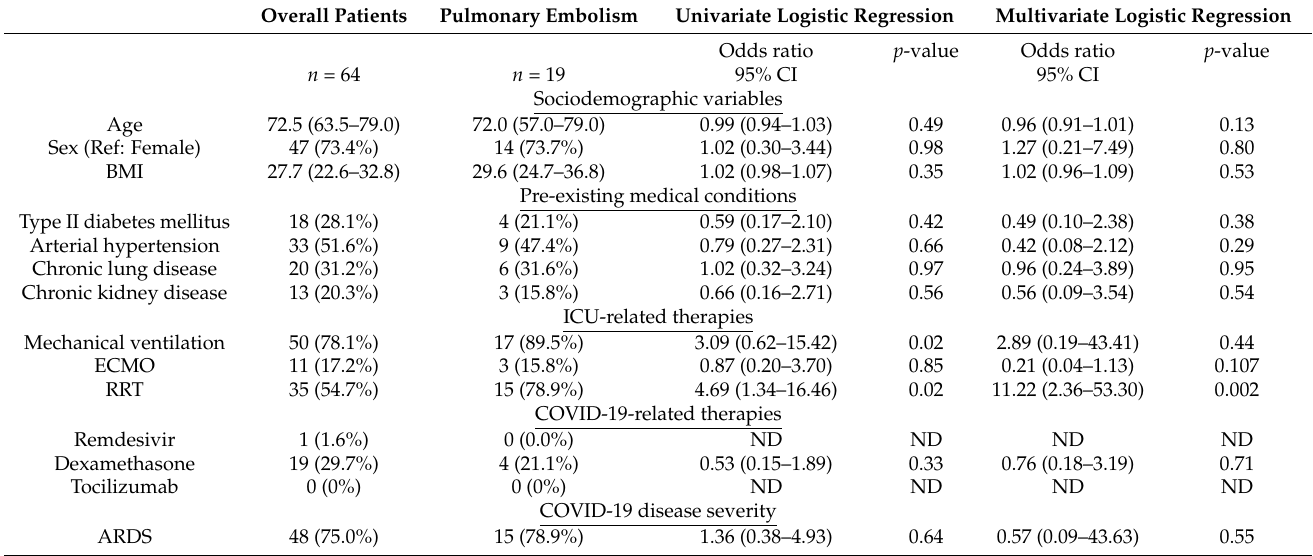
Table 1. Baseline characteristics of consecutive COVID-19 patients from intensive care units all over the city of Hamburg, autopsied at the Institute of Legal Medicine (University Medical Center Hamburg-Eppendorf, Germany), are illustrated ( n = 64). Patients were grouped according to the postmortem diagnosis of pulmonary embolisms. Numbers with frequencies and median with interquartile ranges are illustrated. Univariate and multivariate logistic regressions were performed. Odds ratios with 95% confidence intervals are given. Model estimators: Wald chi-square test: 17.29, p = 0.14; Akaike’s information criterion (AIC): 88.30. Abbreviations: BMI, body mass index; ICU, intensive care unit; ECMO, extracorporeal membrane oxygenation; RRT, renal replacement therapy; COVID-19, coronavirus disease 2019; ARDS, acute respiratory distress